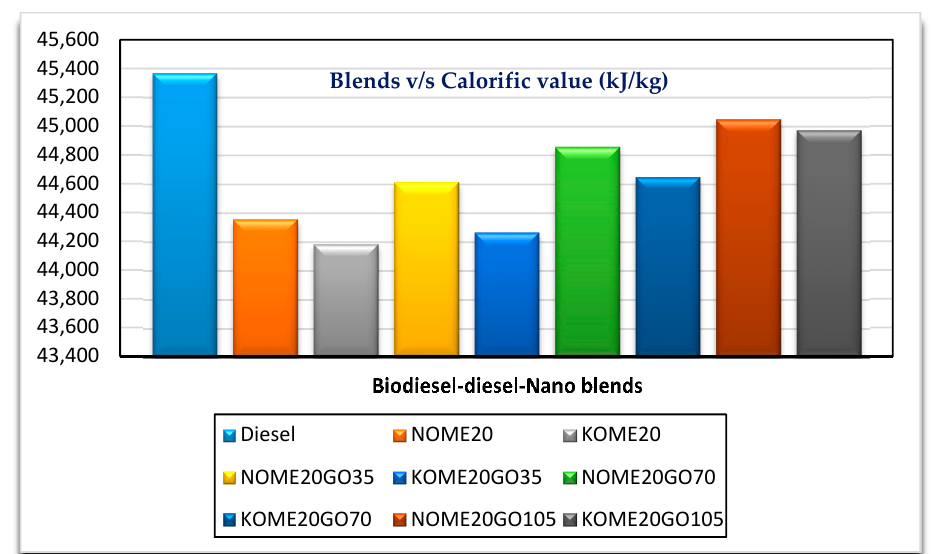
Figure 6. Variation of calorific value with Biodiesel-Diesel-Nano blends.